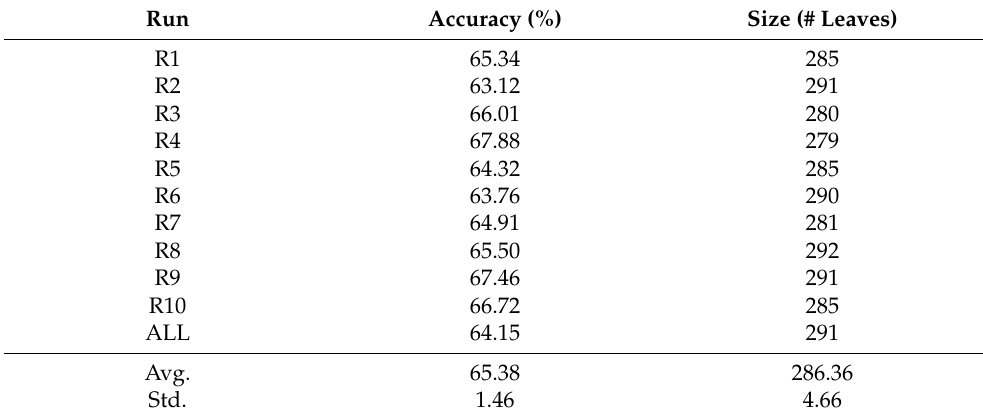
Table 3. Results for 10 runs of the incremental Hoeffding tree learning process—the subsets